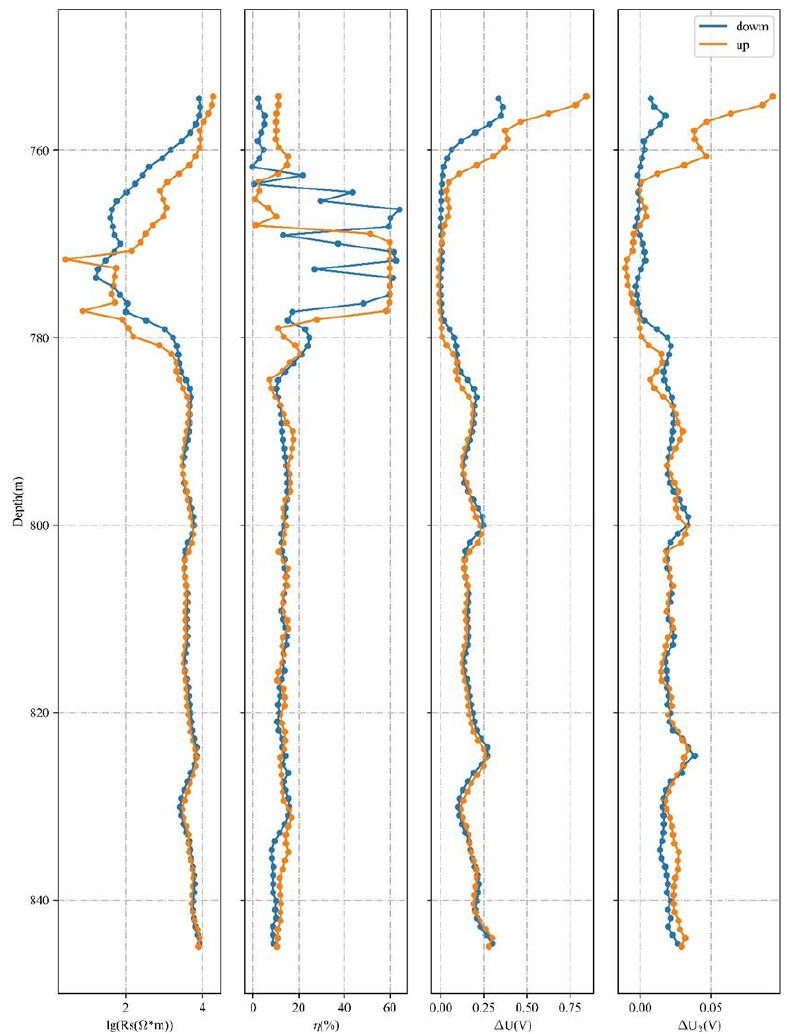
Figure 23. Variations in the induced polarization parameters with depth in the mine section. The low apparent resistivity anomaly was located between 760 m and 790 m, and the minimum resistivity was about 50 Ω∙ m. The resistivity of the monzonite porphyrite above the orebody was 5000 –8000 Ω∙m, and the resistivity of the marble below the orebody was 4000 –5000 Ω∙m. The center of the anomaly was at a depth of 775 m. The anomaly was not completely symmetric, indicating that the orebody was tilted. The IP parameters obtained during the upward and downward movement were plot- ted on the same depth map (Figure 23), and it can be seen that the curves are in good agreement. The fitting degrees of the apparent resistivity curve and the chargeability curve are 0.85 and 0.95, respectively, indicating that the device has good performance and data quality. 2. Borehole IP parameters and interpretation Figure 1c shows the schematic diagram of the borehole IP device. Transmitting elec- trode A generated a current in the borehole. The parameters were: a bipolar square wave